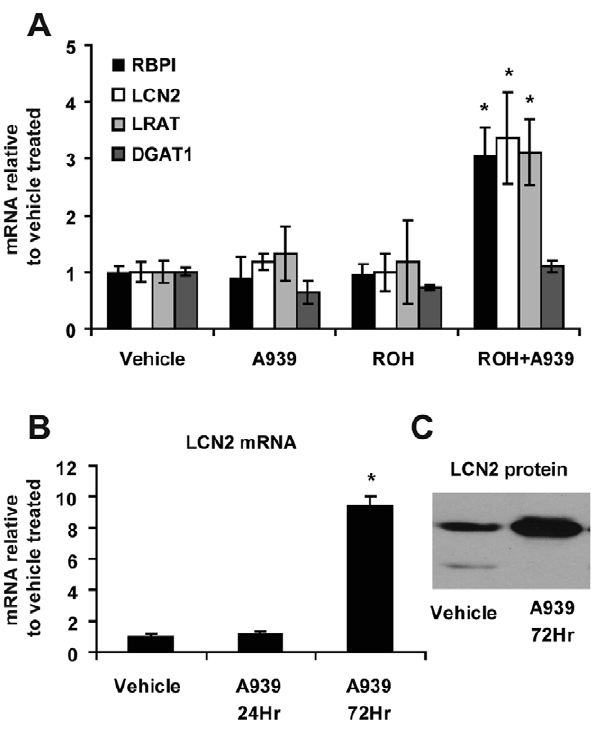
Figure 3. Loss of SCD1 activity in SEB-1 sebocytes increases retinoic acid target gene induction. A) SEB-1 human sebocytes were treated with vehicle alone, the SCD inhibitor A939572 (A939; 1 m M), free retinol (ROH; 1 m M), or both A939 and ROH for 18 hours. Total RNA was collected for assessment of expression of RBP1 , LCN2 , LRAT and DGAT1 . Data are expressed relative to vehicle treated cells. B) SEB-1 cells were grown for the indicated times in the presence or absence of A939572 (A939; 1 m M) and total RNA was collected for assessment of LCN2 induction. C) Cellular protein expression of LCN2 increased after 72 hour treatment with A939 as well. Data represent mean 6 SEM for n=3 per group. *= p , 0.05 vs. vehicle control.